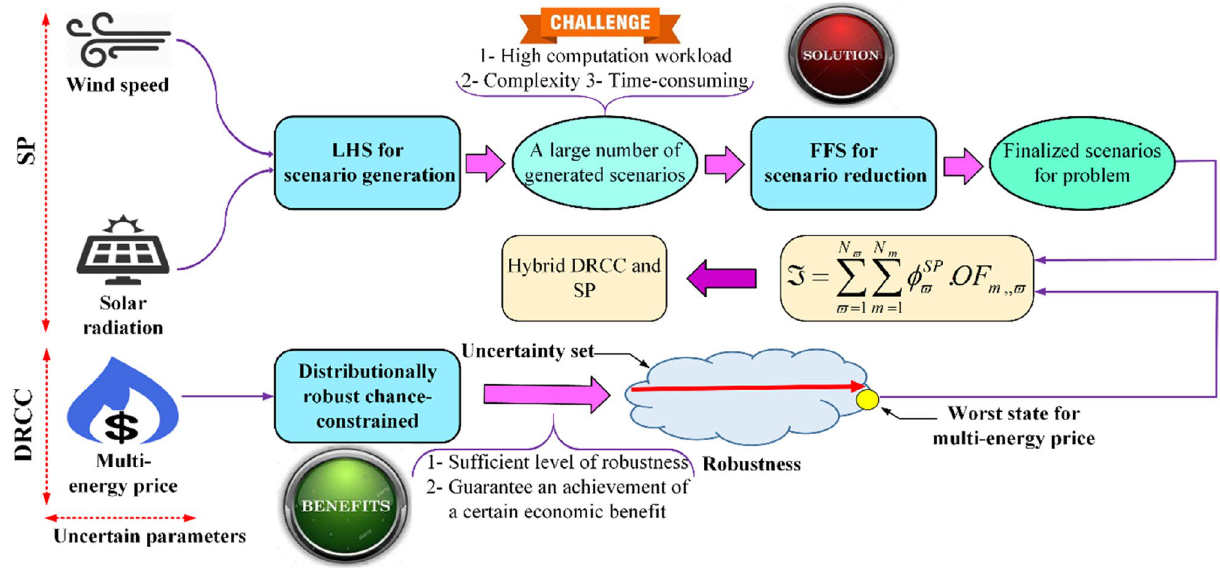
Figure 8. Schematic of the proposed hybrid uncertainty modeling method. It indicates a novel method for modeling uncertainties in energy networks with 100% RESs considering the uncertain behaviors of different uncertain parameters along with the robustness degree of the